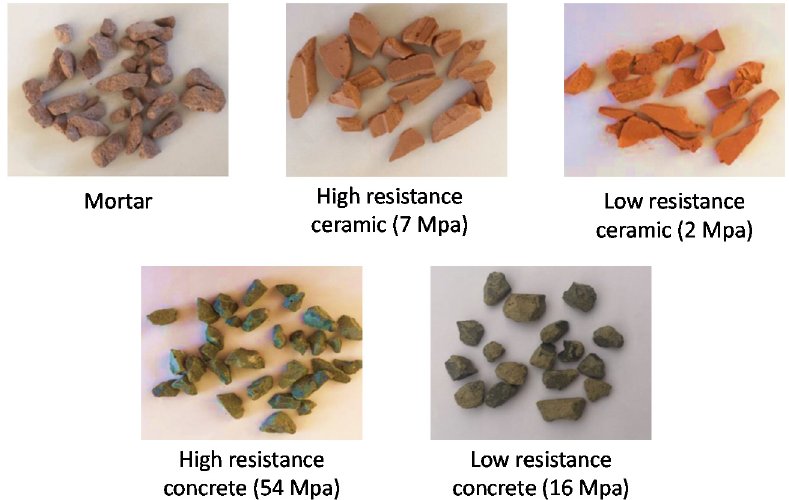
Figure 1. Pictures of aggregates after crushing and classification.